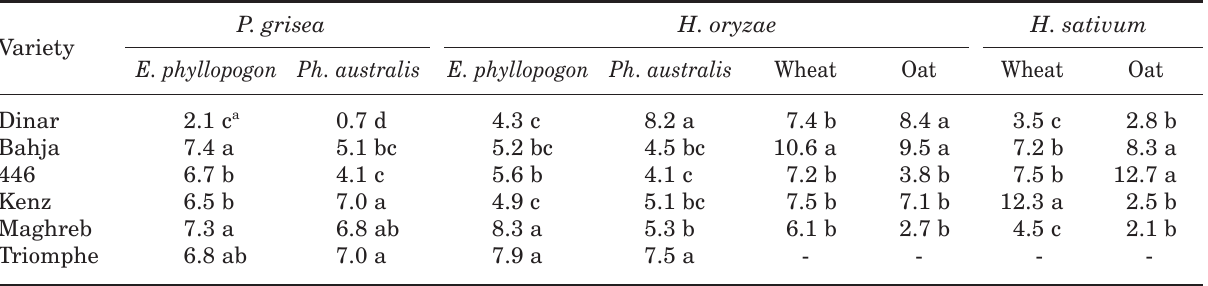
Table 3. Sporulation (spores/cm 2 ) of Pyricularia grisea , Helminthosporium oryzae and H. sativum isolated from wheat, oat, Echinochloa phyllopogon and Phragmites australis on leaves of six rice